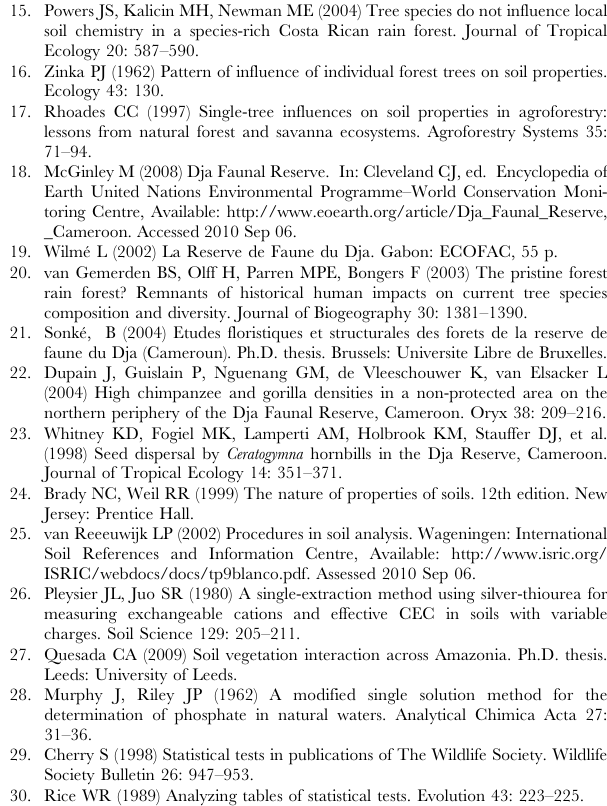
Table S1 Detailed soil description of the pits (200-cm depth) from the three pairs of 1 ha forest plots at the Dja Faunal Reserve. The pairs were G1-M1, G2-M2, and G3-M3. Table S2 Concentrations of Al, Ba, Ca, Cu, Fe, K, Mg, Mn, Na, Ni, Si and Zn found in soils at different depths sampled beneath plots of forest dominated by Gilbertiodendron dewevrei (G1, G2, G3) and adjacent higher-diversity forests where no species dominates